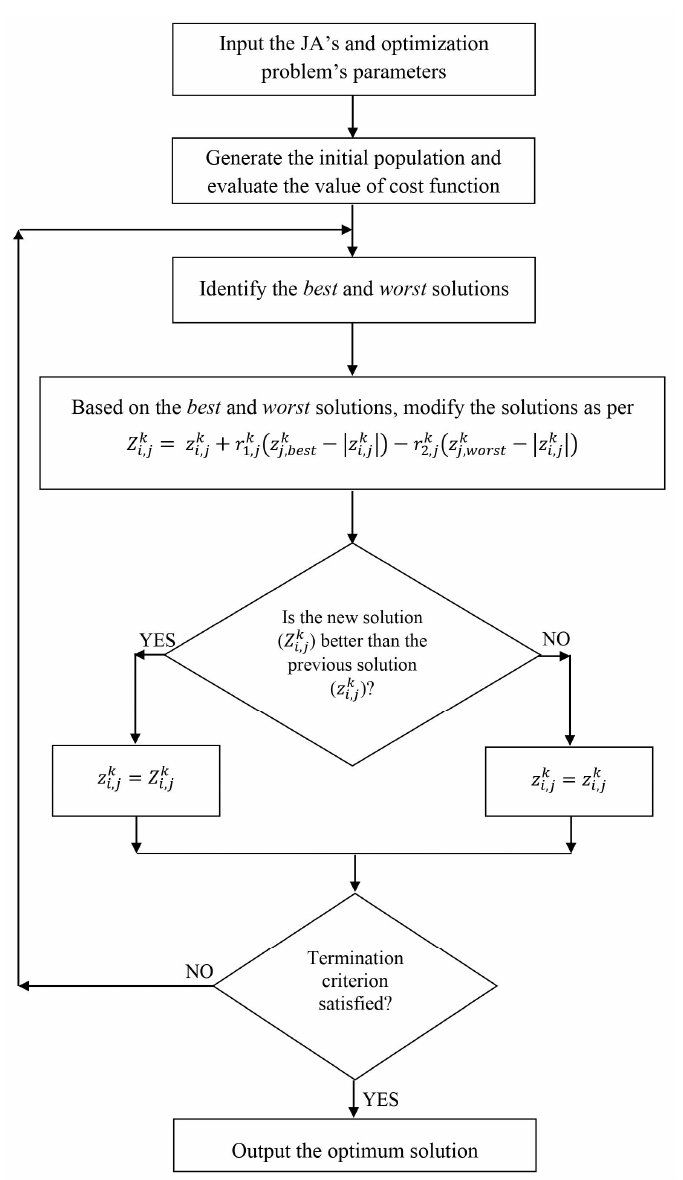
Figure 4. Execution cycle of the Jaya algorithm.